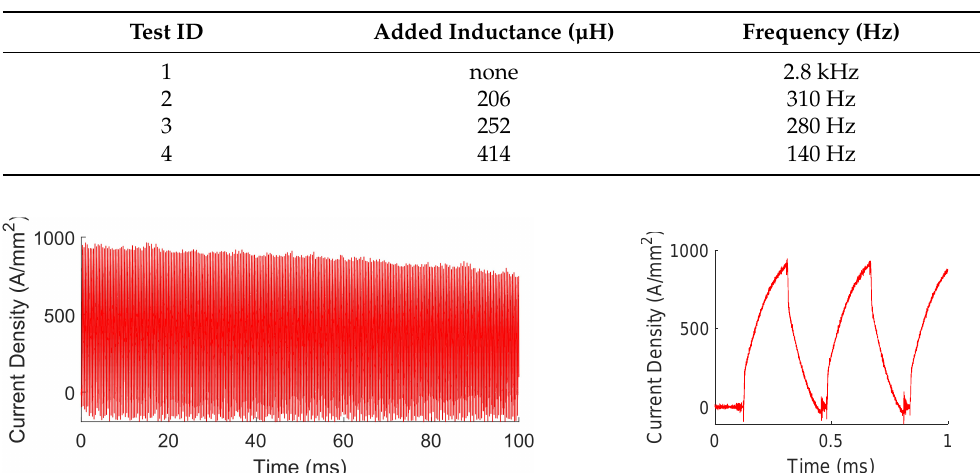
Table 3. Battery bank parameters used in tests shown in Figure 18.